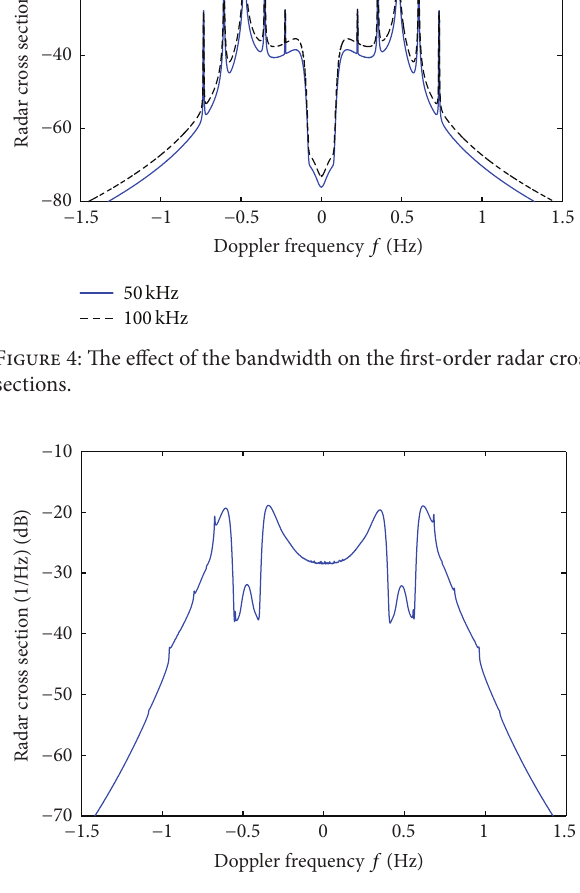
Figure 5: Second-order bistatic radar cross section with a transmit- ter on a floating